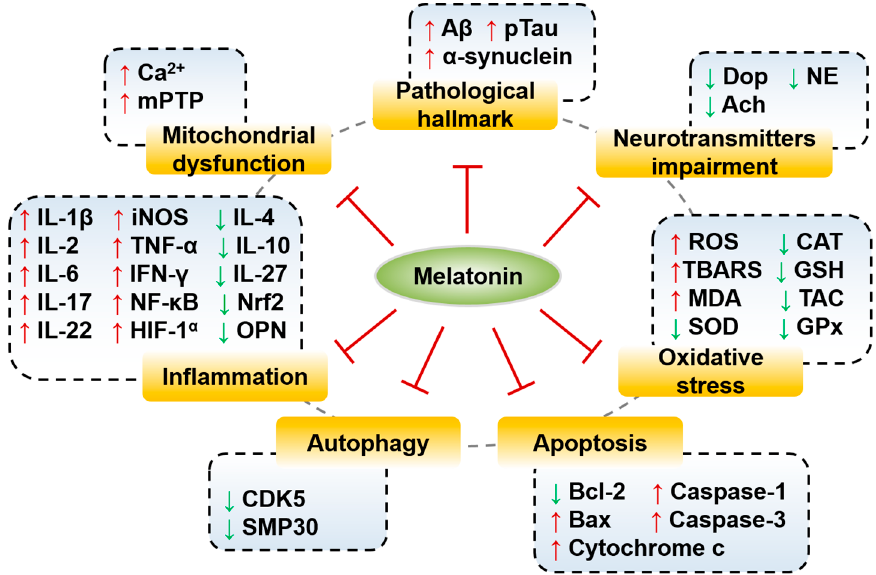
Figure 1. Schematic representation of melatonin therapy by targeting molecular signaling pathways in neurodegenerative diseases with different pathogenic mechanisms. Melatonin inhibits pathological hallmarks, oxidative stress, inflammation, neurotransmitter impairment, mitochondrial dysfunction, apoptosis and autophagy. mPTP, mitochondrial permeability transition pore; Dop, dopamine; Ach, acetylcholine; NE, norepinephrine; TBARS, thiobarbituric acid reactive substances; CAT, catalase; GSH, glutathione; TAC, total antioxidant capacity; GPx, glutathione peroxidase; MDA, malondialdehyde; ↑ , induction; ↓ ,